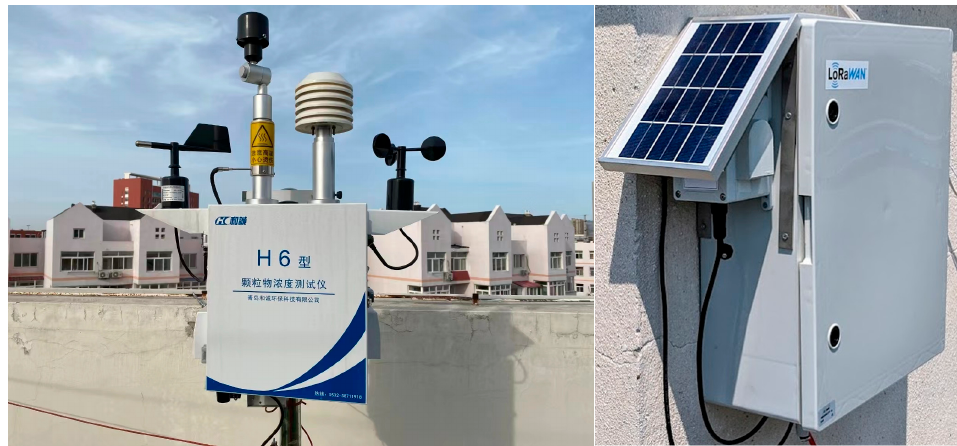
Figure 5. Commercial AQI monitoring stations, used by EMULSION.